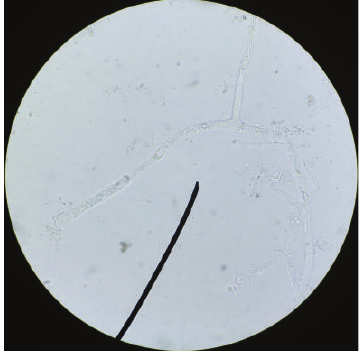
Figure 2: 20% KOH wet mount showing broad hyaline sparsely septate hyphae (2-3 septa).